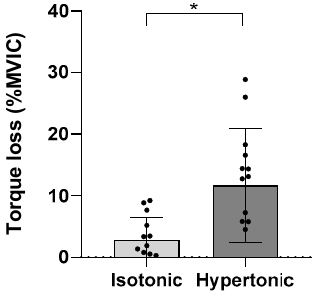
Figure 2. Torque loss after injection with isotonic and hypertonic solutions when compared to torque produced during pre-injection MVIC. * Significant difference between saline solutions ( p < 0.05).